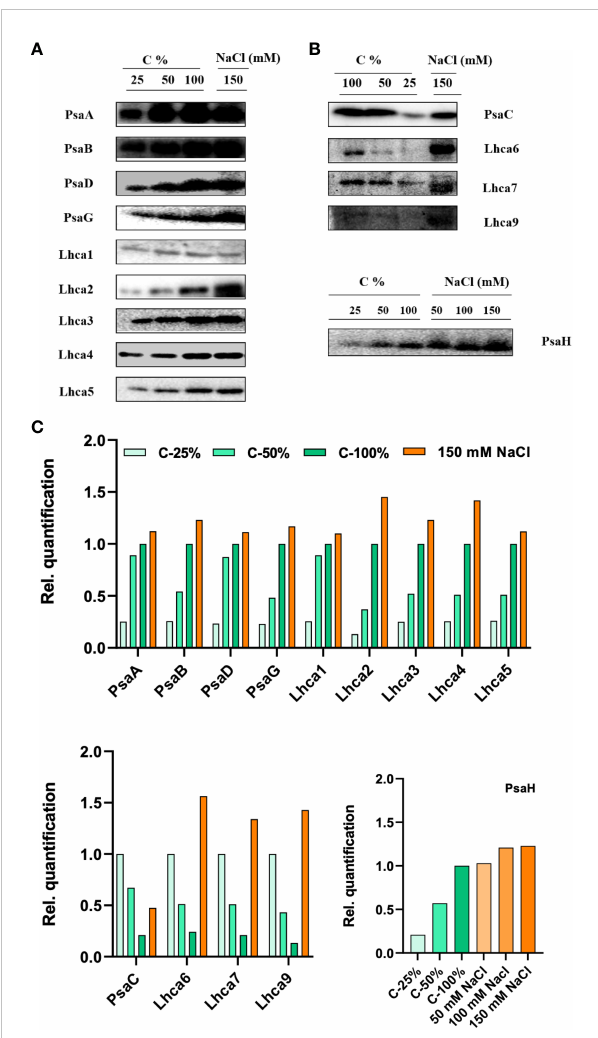
FIGURE 10 Protein pro fi le analysis of thylakoid membranes isolated from control and 150 mM sodium chloride (NaCl) treated C. reinhardtii cells, (A) probed with photosystem (PS)I core antibodies (PsaA, PsaB, PsaC, PsaD, PsaG, and PsaH) and (B) LHCI complex proteins, (Lhca1, Lhca2, Lhca3, Lhca4, Lhca5, Lhca6, Lhca7, and Lhca9). Two micrograms of Chl was loaded on to each well. (C) Relative band density from each lane was calculated by ImageJ software. In order to compare the loading control, the wild-type samples were loaded with different dilutions (25, 50, and 100%).